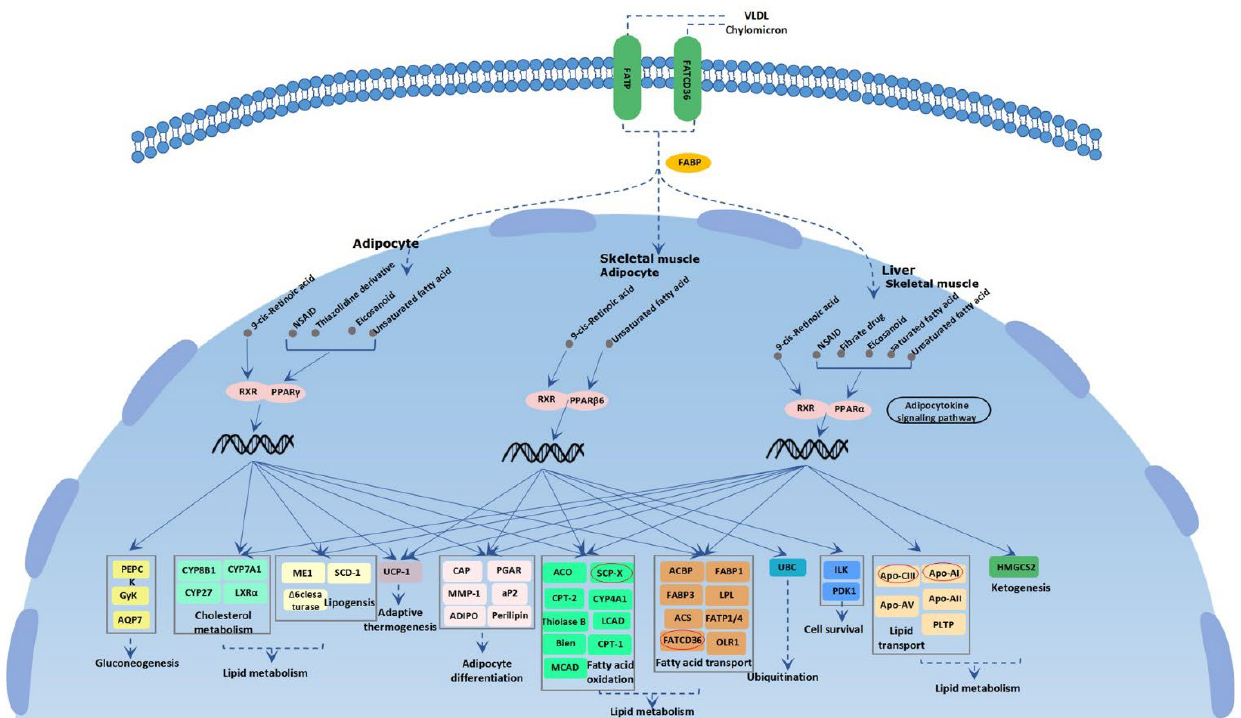
Figure 3. The overview of the PPAR signaling pathway. The function of the SCP2 , APOA1 , CD36 , and APOC3 are described in the figure and marked with red ellipses.